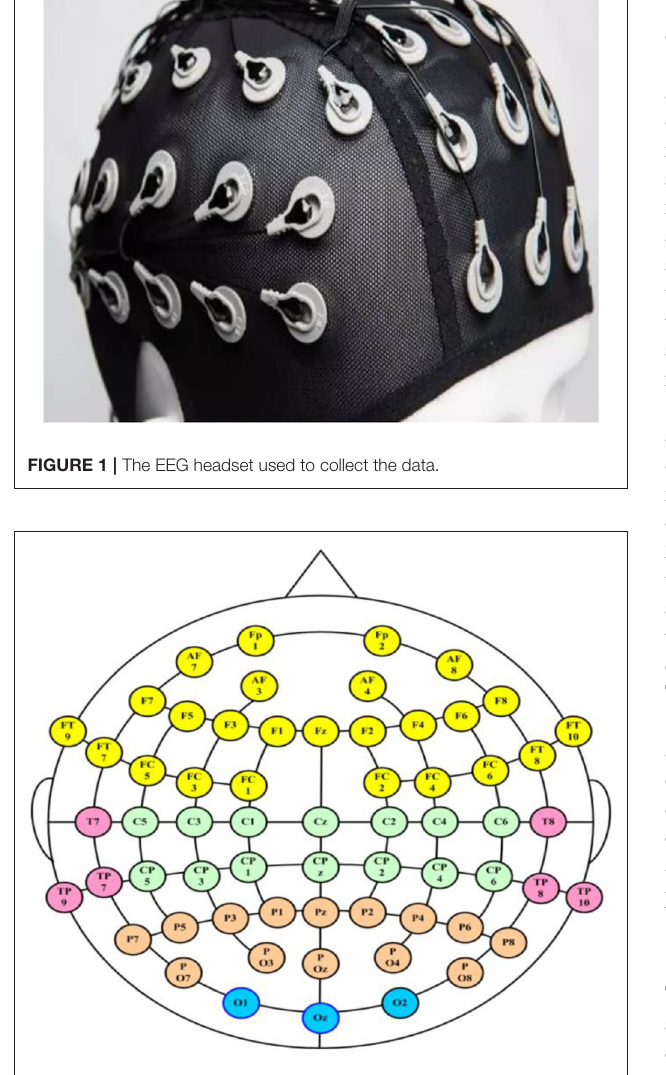
the reference electrodes. The channel location is shown in Figure 2 . The EEG data were collected with electrode impedances below 10 k (cid:127)